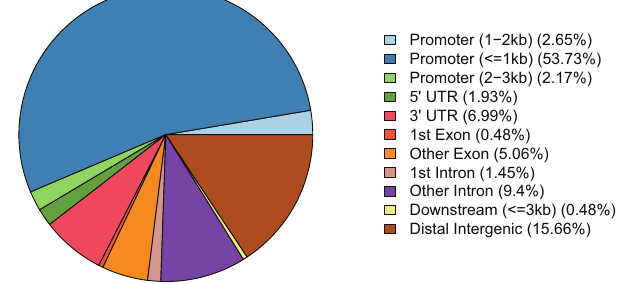
Figure 16. Feature distribution: annotation the region of the